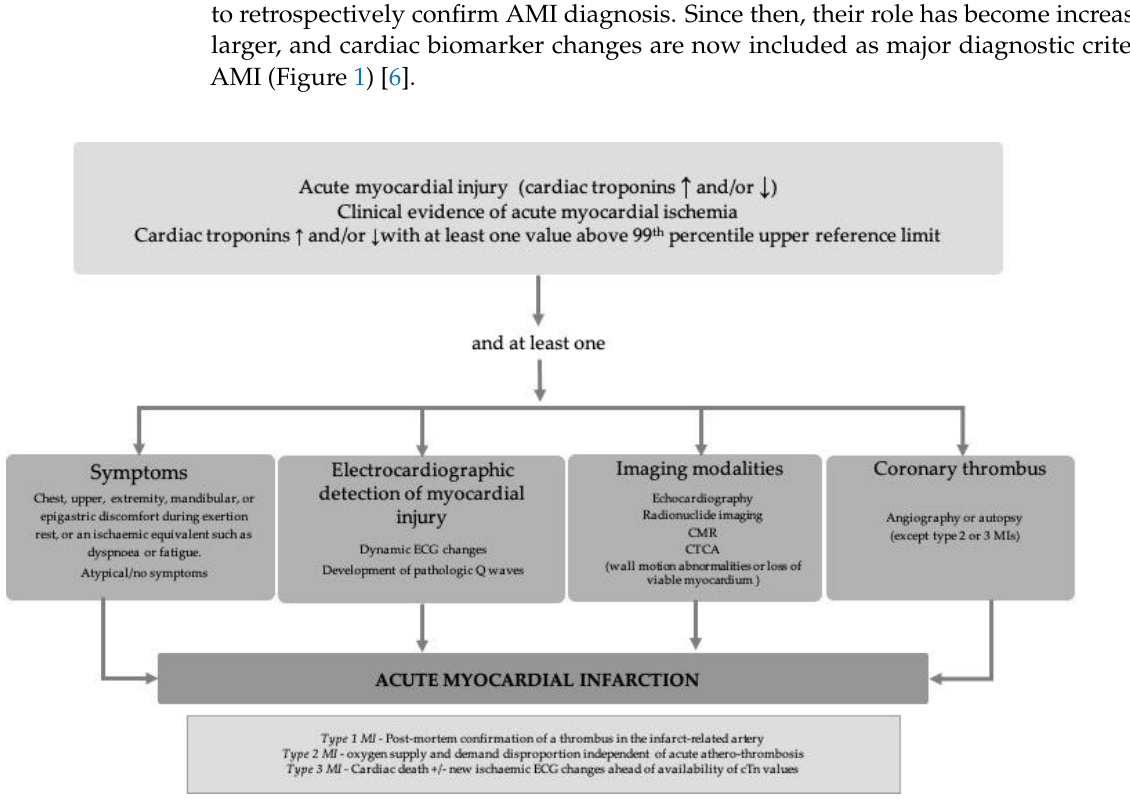
Figure 1. Schematic diagram of the universal definition of acute myocardial infarction, adapted from [7]: CMR—cardiac magnetic resonance; CTCA—computed tomographic angiography; MI—myocardial infarction; cTn—cardiac troponins.